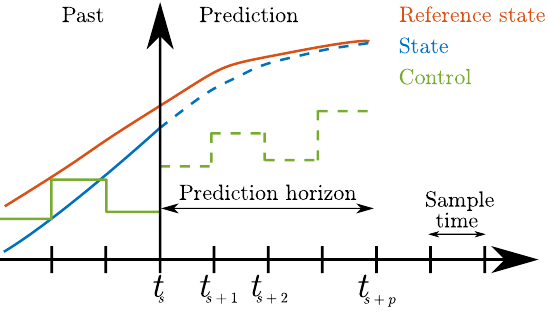
Figure 9. Sketch of the MPC method. Due to the real-time constraints, the optimization problem has to be solved faster than the sample time h